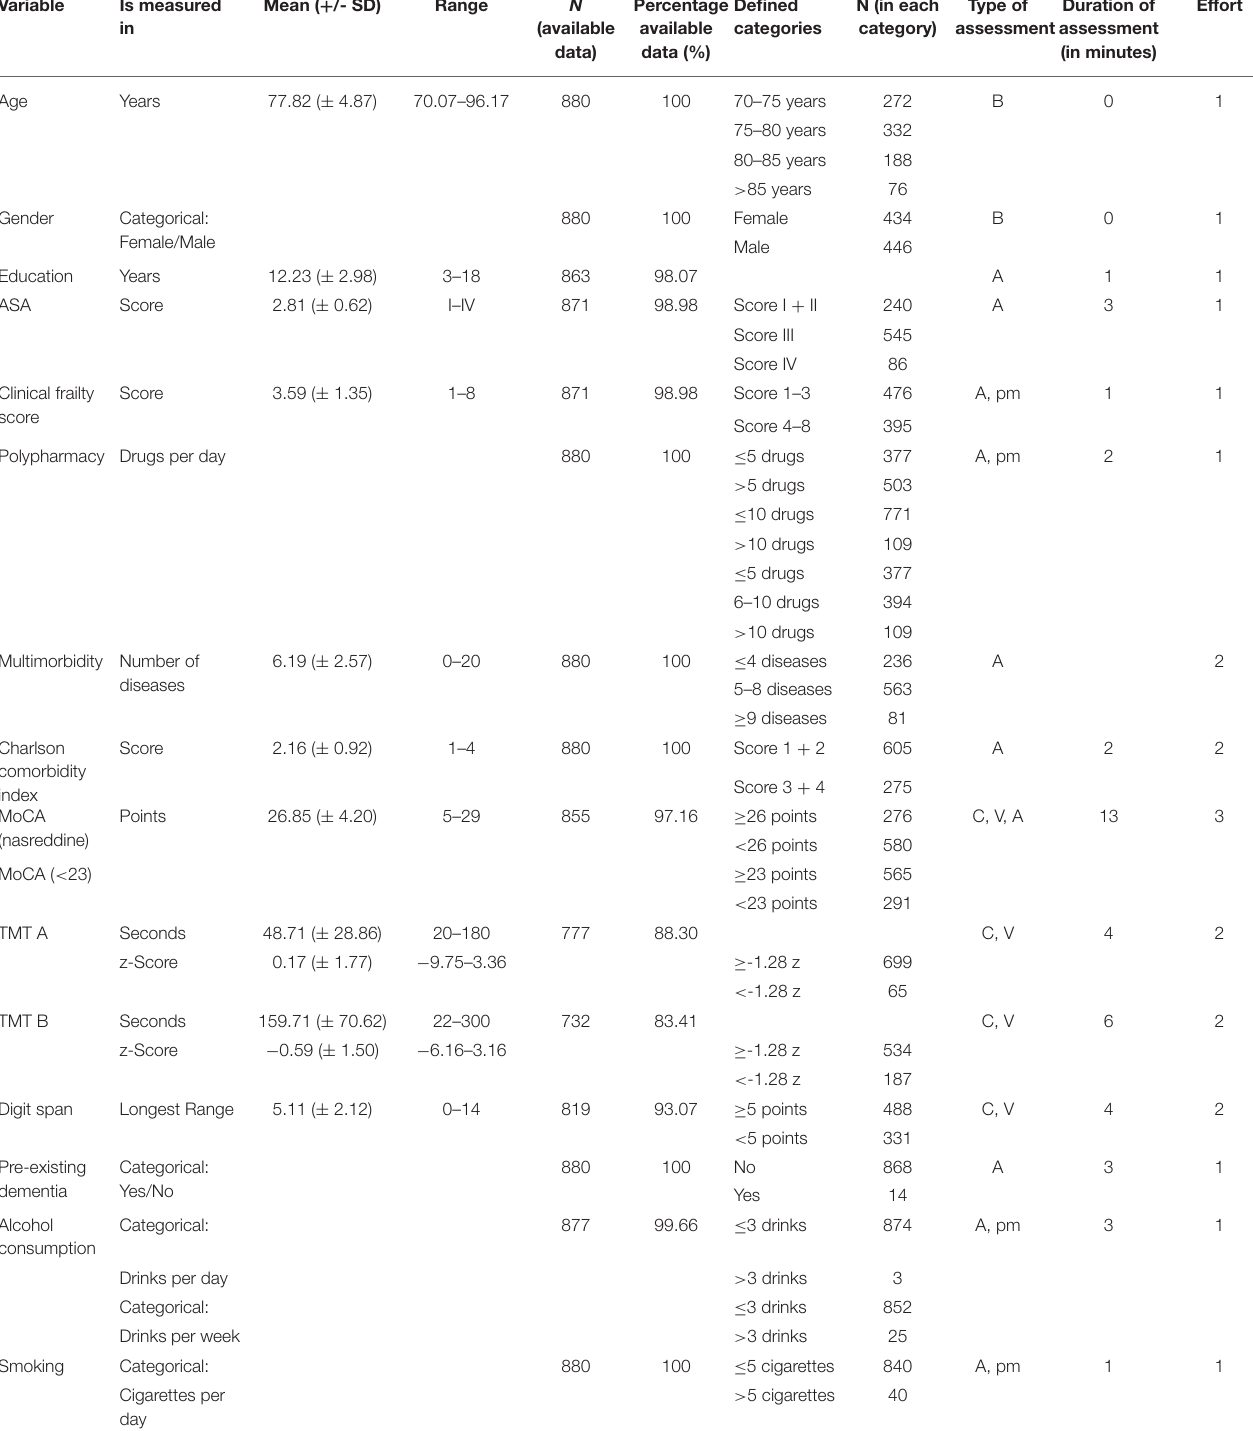
TABLE 1 | Overview of basic characteristics for whole sample.